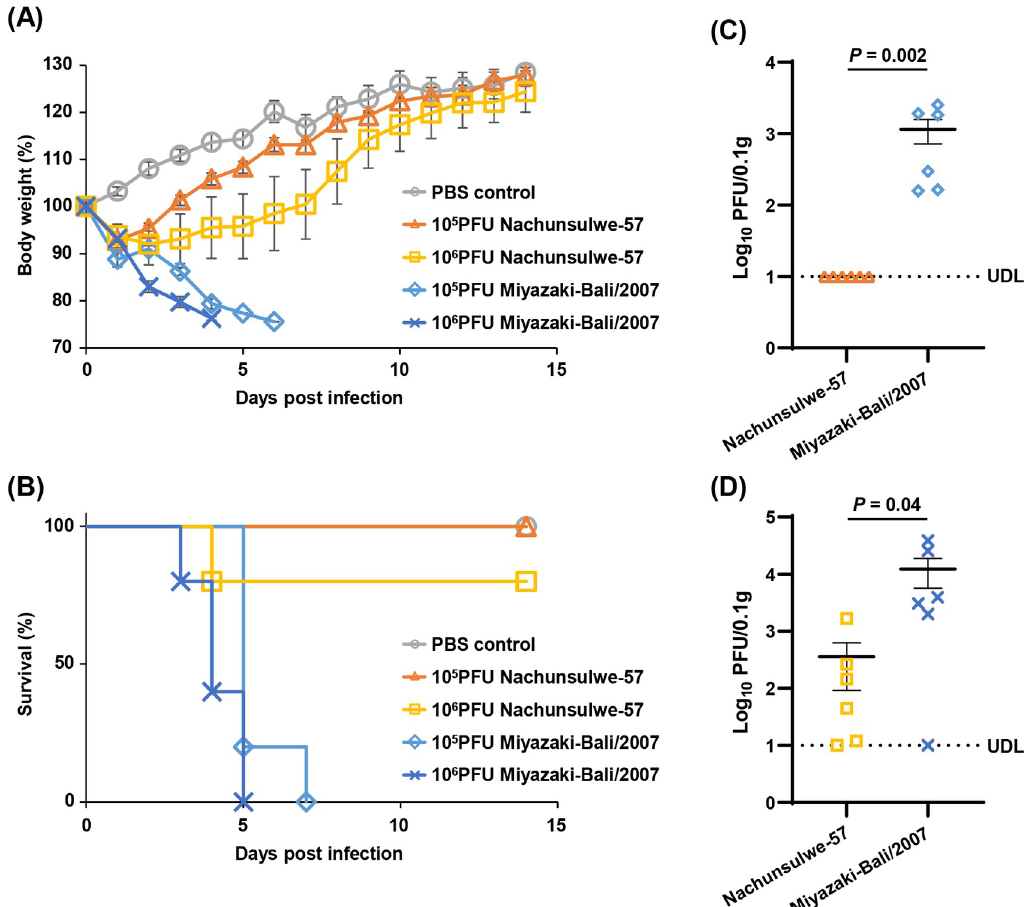
Fig 5. Pathogenicity of Nachunsulwe-57 and Miyazaki-Bali/2007 strains in mice. (A and B) Four-week-old female BALB/c mice were infected with Nachunsulwe-57 or Miyazaki-Bali/2007 at 10 5 or 10 6 PFU intranasally. Body weight (A) and survival rate (B) were monitored daily for 14 days. Each value represents mean ± SEM, n = 5. (C and D) At 4 dpi, viral titers in the lungs of BALB/c mice infected with Nachunsulwe-57 or Miyazaki-Bali/2007 at 10 5 (C) and 10 6 PFU (D) were examined. Each value represents mean ± SEM for each group, n = 6. The indicated P -values were analyzed by the Mann-Whitney U test. Dashed line indicates the limit of detection. UDL, under detection limit.